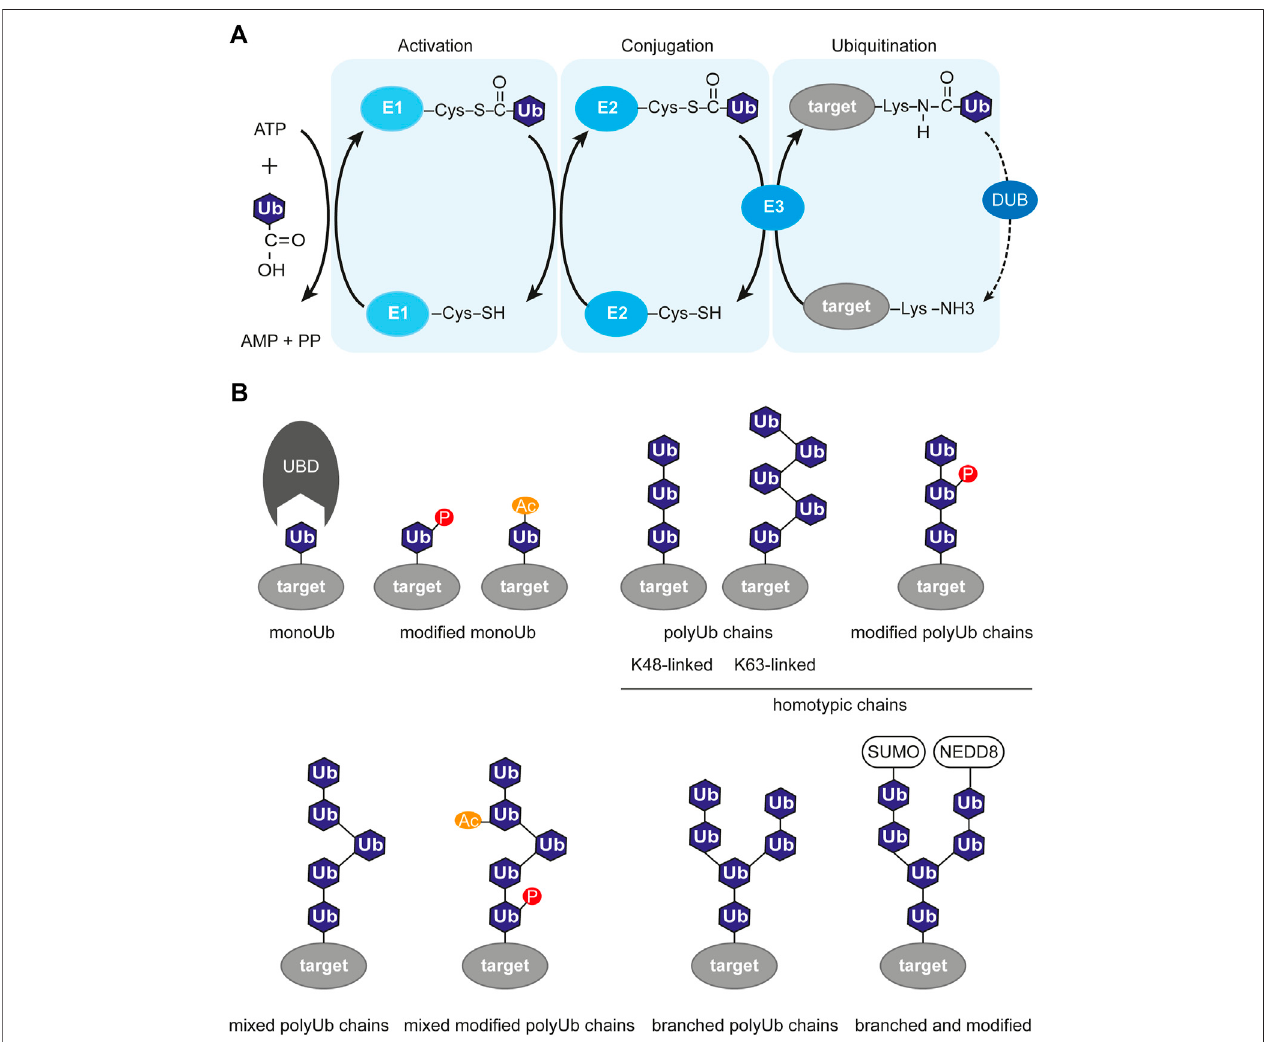
FIGURE 2 | Ubiquitin-dependent signaling system. (A) Enzymatic cascade of ubiquitination involving three enzymes. The fi rst step is activation of ubiquitin and covalent attachment to the E1 enzyme. The second step is conjugation, where ubiquitin is transferred to the E2 enzyme. The last step is the transfer of (poly)- ubiquitination to it ’ s target molecule mediated by a E3 ligase. The ubiquitination process is opposed by deubiquitination, which is the removal of the ubiquitin mark from the target protein by deubiquitinase (DUB). (B) Variety of ubiquitin chains, with or without modi fi cations. P, phosphorylation; Ac, acetylation; SUMO, SUMOylation; NEDD8, NEDDylation; Ub, ubiquitin; UBD, ubiquitin-binding domain; target, target protein harboring ubiquitin modi fi cation.